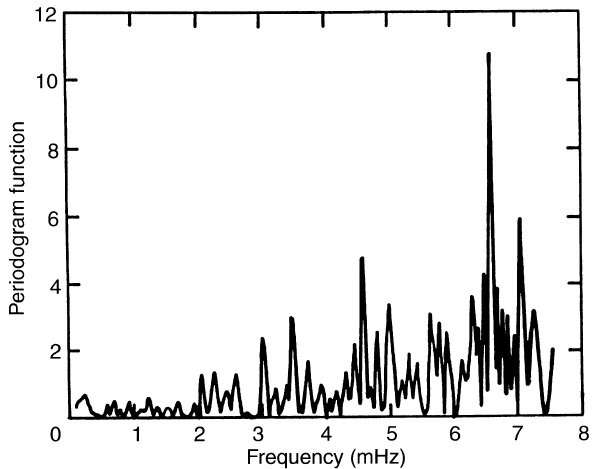
Fig. 1. The power spectrum density of secondary particle fluxes registered on balloon flight over Bauru on 22 April 1989